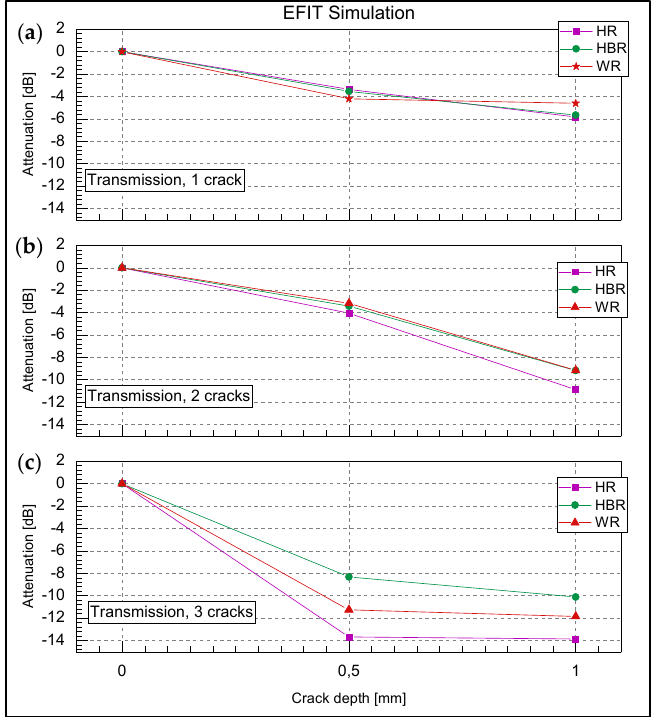
Figure 14. Attenuation of transmitted R-wave with respect to the undamaged state depending on crack depth, number of cracks and receiver location; ( a ) for 1 crack, ( b ) 2 cracks, ( c ) 3 cracks.